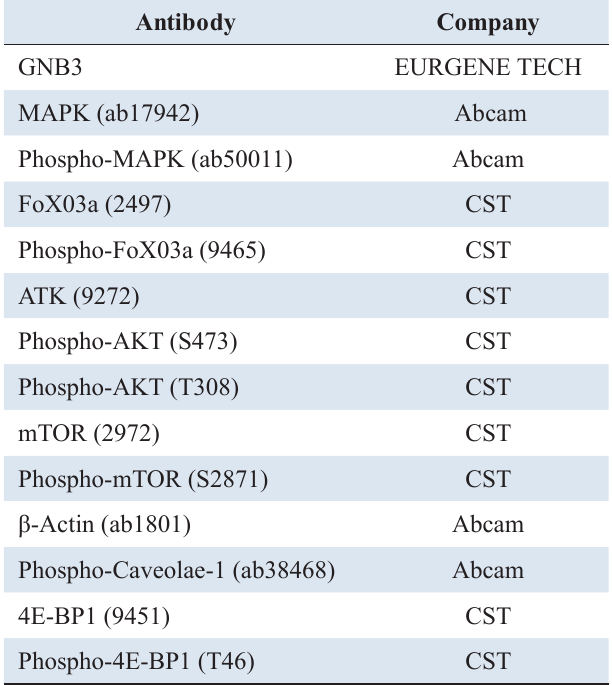
Table 1. Antibodies used in the study.